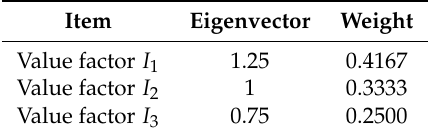
Table 8. The result of calculation of W 1 from I 0 .